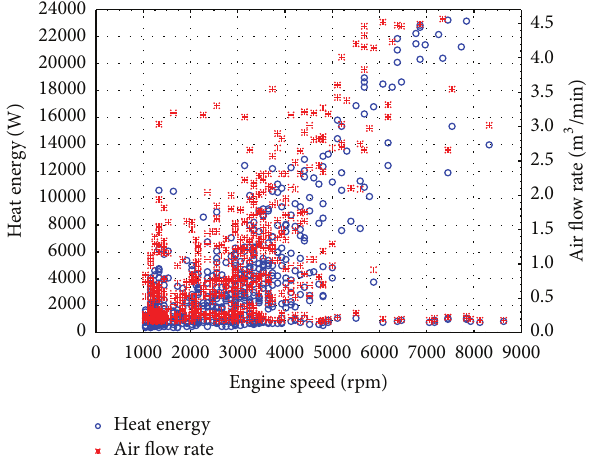
Figure 4: Heat energy from exhaust gas of experimental vehicle on engine speed and air flow rate.